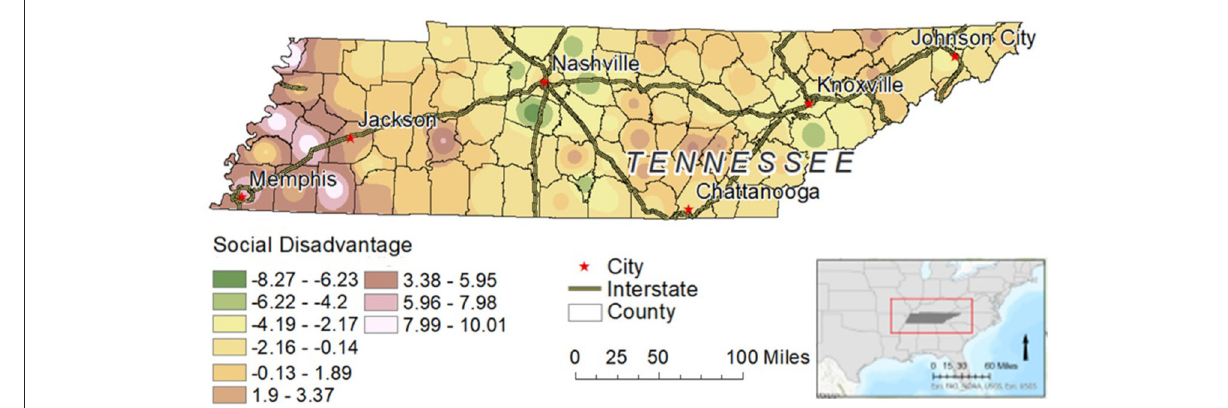
FIGURE3 Distribution of socially disadvantaged communities in Tennessee at the county level.